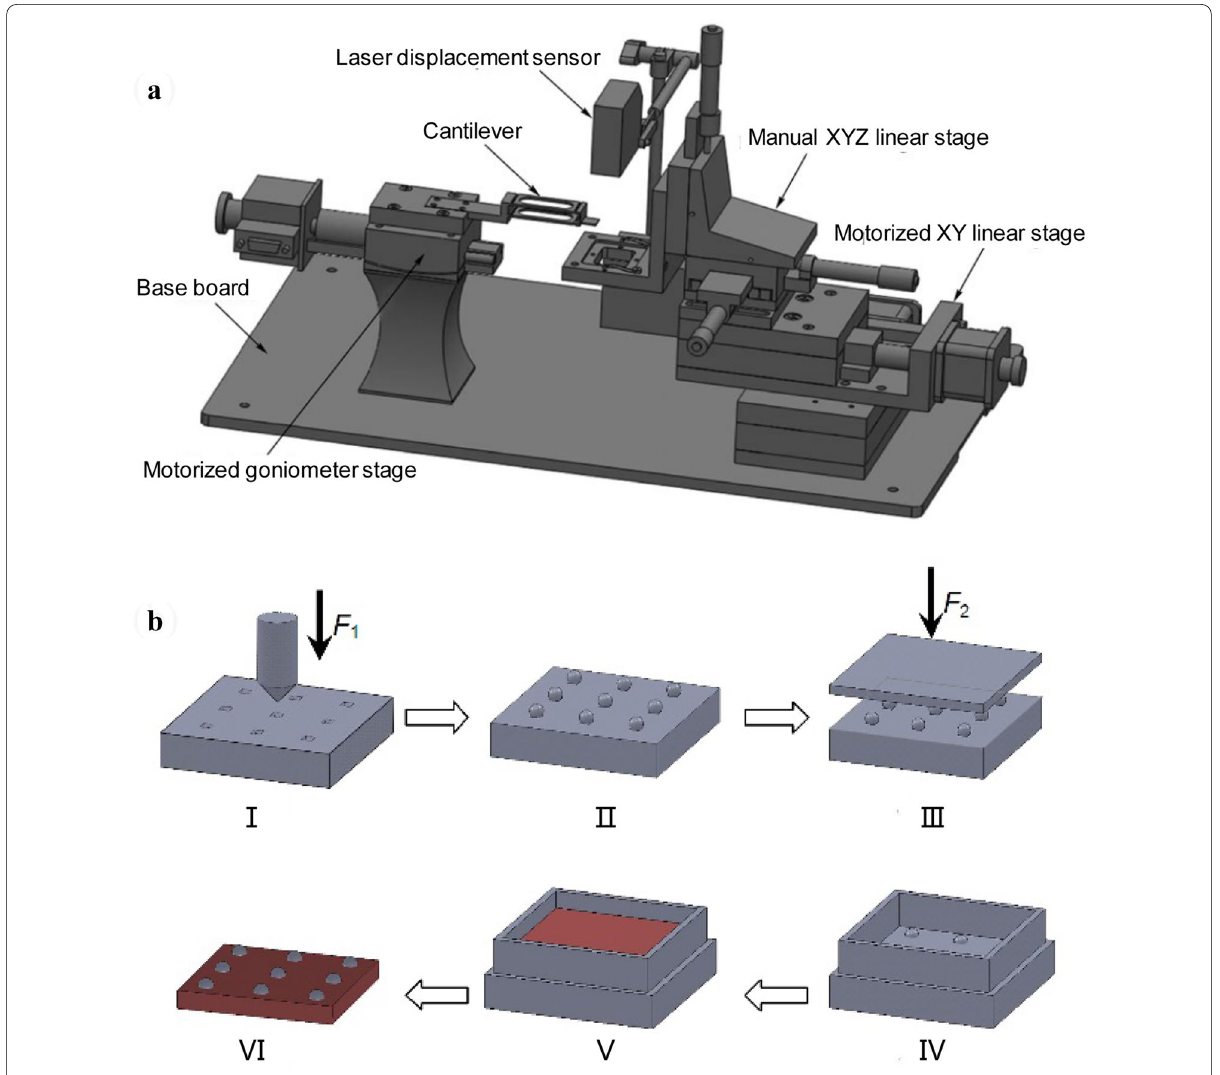
Figure 26 Schematic illustration of ( a ) mechanical part of the multi-probe fabrication apparatus, and ( b ) the preparation of multi-probe array [94,